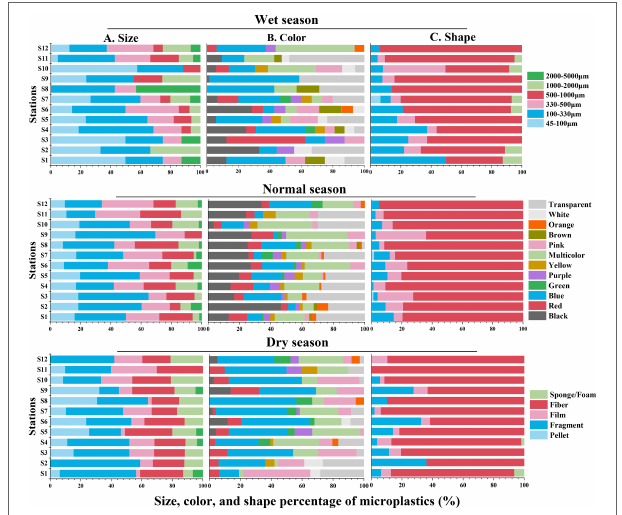
FIGURE 3 | Spatiotemporal composition of MPs from land-based sources in ZJB ( A , size; B , color; and C ,